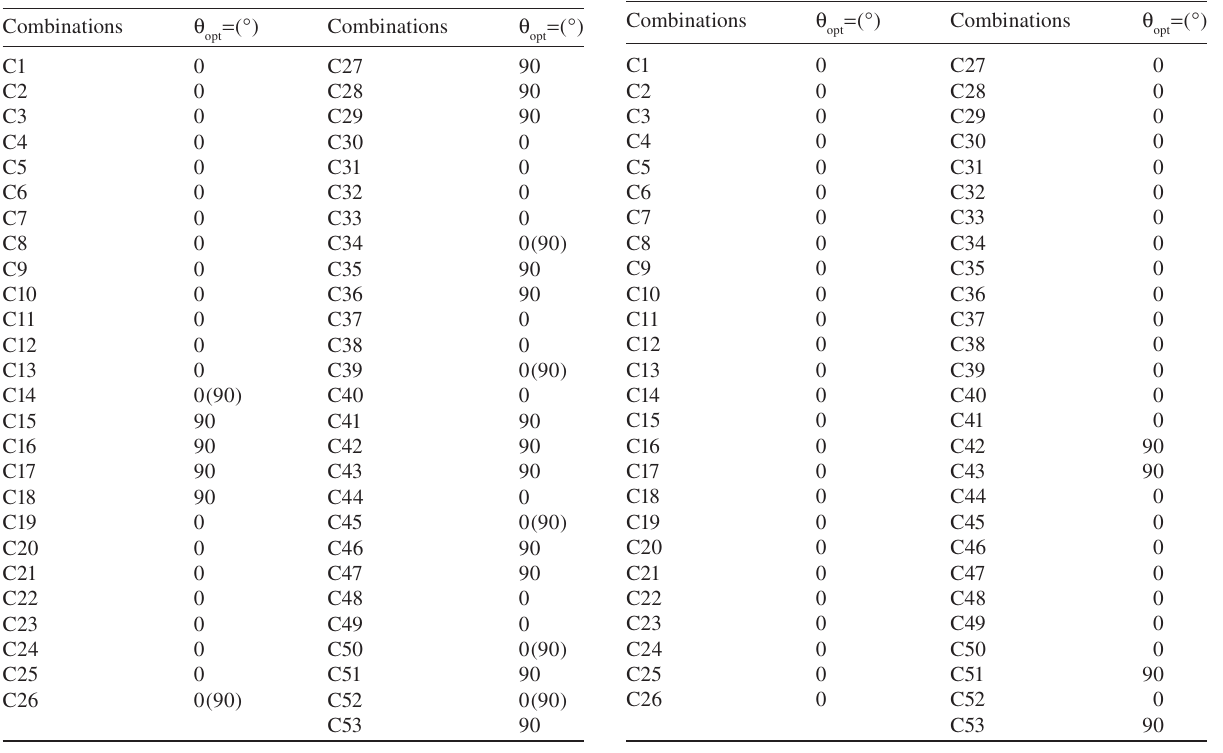
Table 8 Optimum fi ber orientations for laminated plates with intermediate line supports for ( CCCC ) boundary condition.